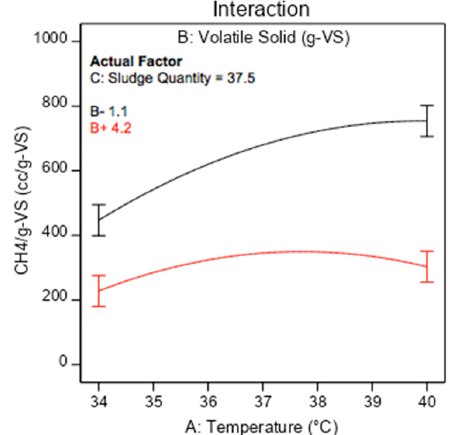
Figure 16. Interaction plot displaying the effects of interaction between temperature and volatile solid on CH 4 g –1 -VS.